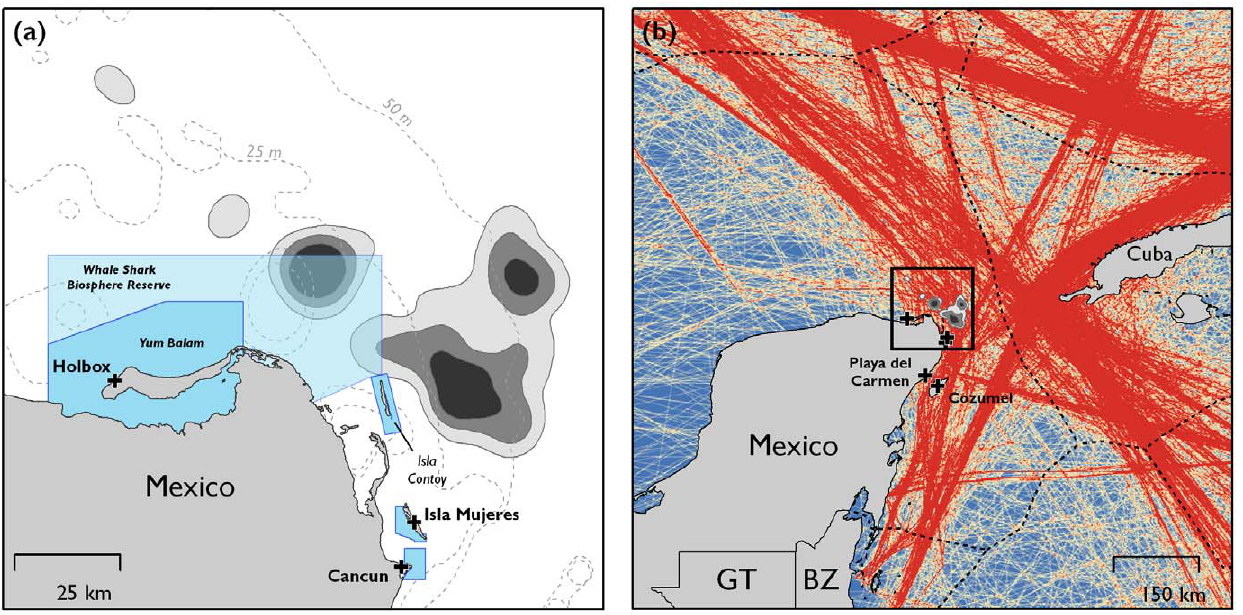
Figure 2. Utilisation distribution of manta ray locations (a) (quartic kernelling; grey polygons showing 25%, 50%, 75%, from darkest to lightest grey). Blue polygons show marine protected areas, tourism ports are indicated (black crosses). Commercial shipping activity, showing transit of boats belonging to the World Meteorological Organisation Voluntary Observing Ship Scheme (b) (red showing higher density of ship transit) from [41]. Core manta ray foraging areas are indicated, with Mexican tourism ports (Holbox, Isla Mujeres, Cancun, Playa del Carmen and Cozumel).